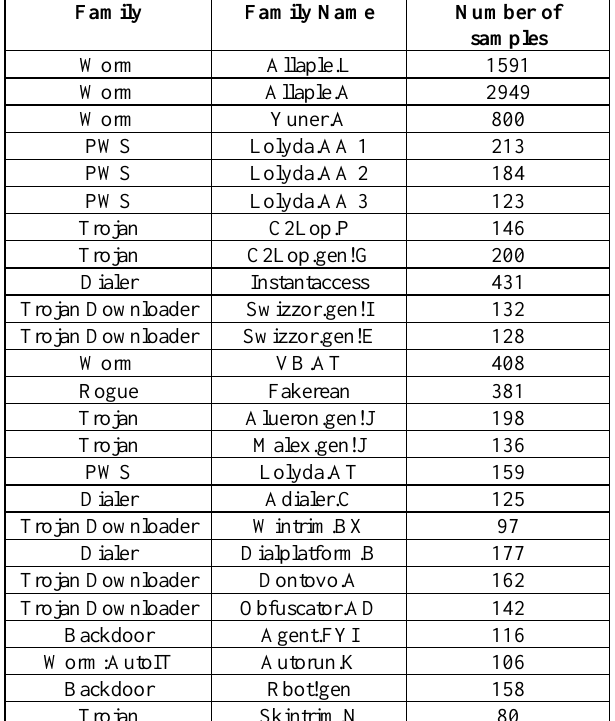
Figure 4. shows the representation of the malware samples,